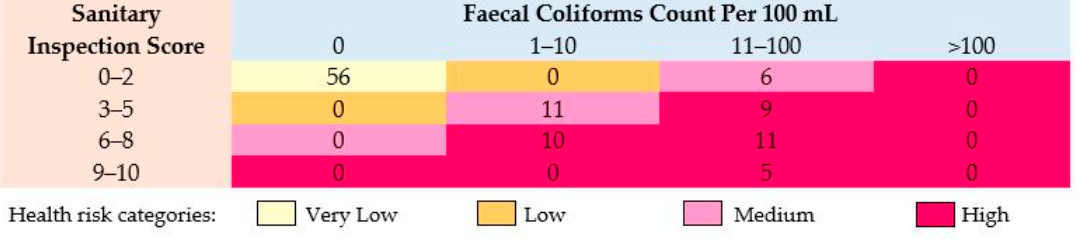
Figure 3. Health risk categories for faecal coliforms for examining the potable water quality of the study area.